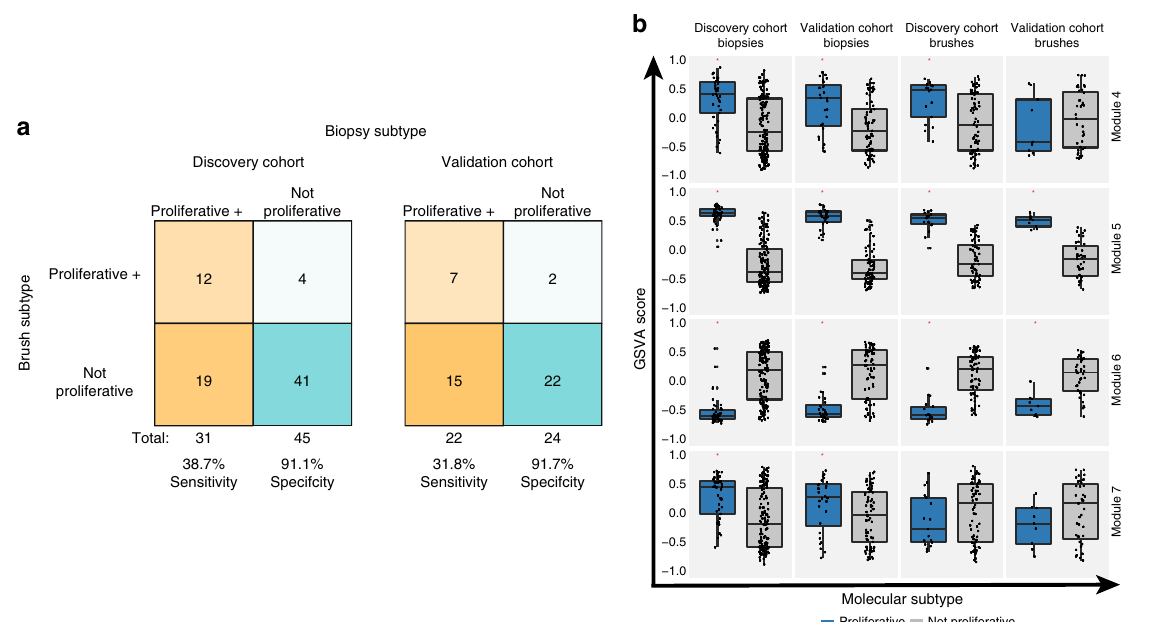
Fig. 3 Normal-appearing bronchial brushes predict the presence of proliferative lesions. a The DC (left) and VC (right) cohorts, showing the number of brushes ( y axis) classi fi ed as proliferative orange) that have at least one biopsy ( y axis) classi fi ed as proliferative at the time the brush was sampled. Brushes/biopsies classi fi ed as not proliferative are turquoise. b Boxplots of GSVA scores for modules 4, 5, 6, and 7 ( y axis) across all brushes ( n = 86 in DC and n = 48 in VC) and biopsies ( n = 190 in DC and n = 105 in VC) from each cohort classi fi ed as Proliferative or not Proliferative ( x axis). The red asterisk indicates signi fi cant differences between the Proliferative subtype versus all other samples (FDR < 0.05, linear model). In the boxplots, the upper and lower hinges correspond to the fi rst and third quartile, center line represents the median, and whiskers extend from the hinge to the largest or smallest value at most 1.5 times the distance between the quartiles. Source data are provided as a Source Data fi